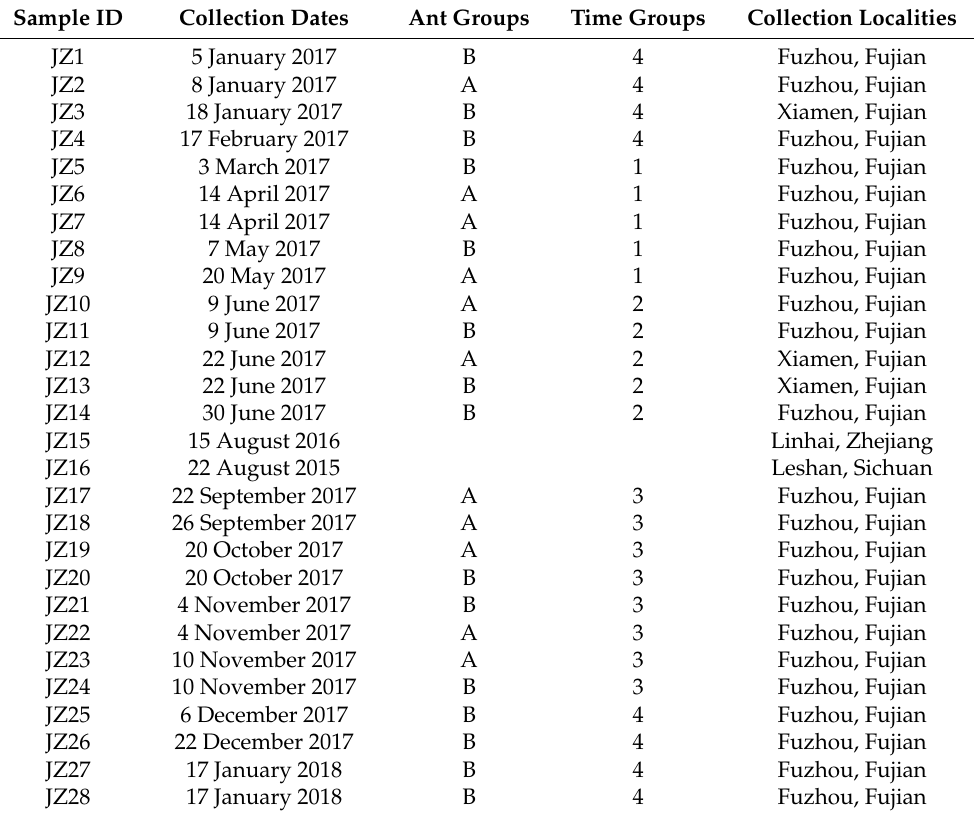
Table 1. Information of Pseudoregma bambucicola samples used in this